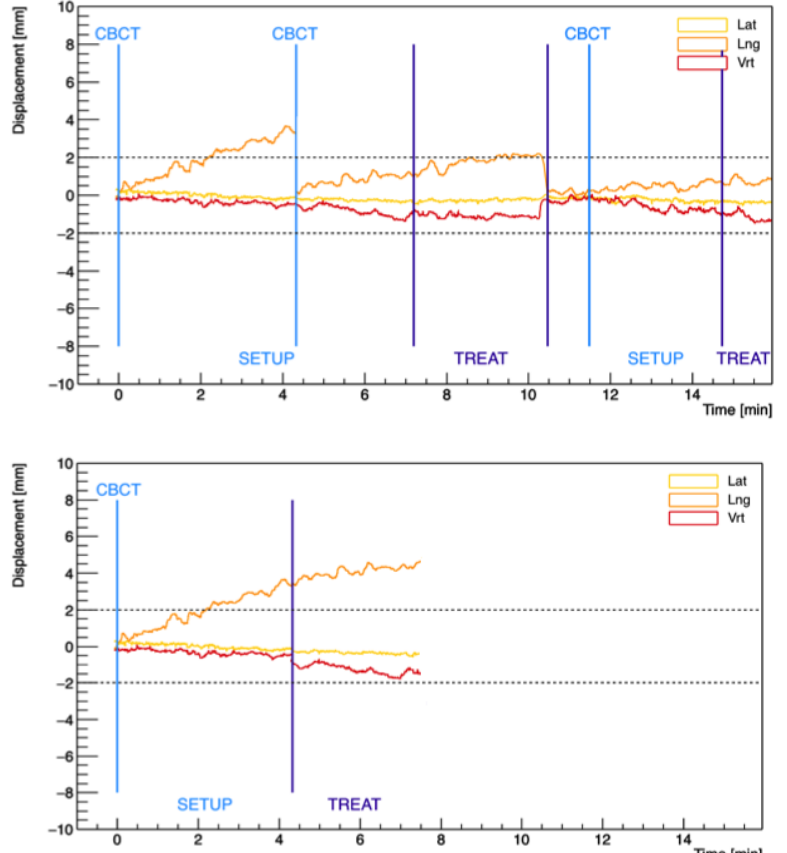
Figure 1. Examples of prostate trajectories in the three spatial directions obtained from case A (gated) ( top ) and case B (non-gated) ( bottom ) motion data for the same treatment fraction. The first light-blue vertical line highlights the tracking starting point (zero position) corresponding to the acquisition of the first CBCT. The following lines indicate every other acquisition of a new CBCT due to prostate displacements beyond the 2 mm threshold. The dark-blue lines separate the setup and delivery phases.